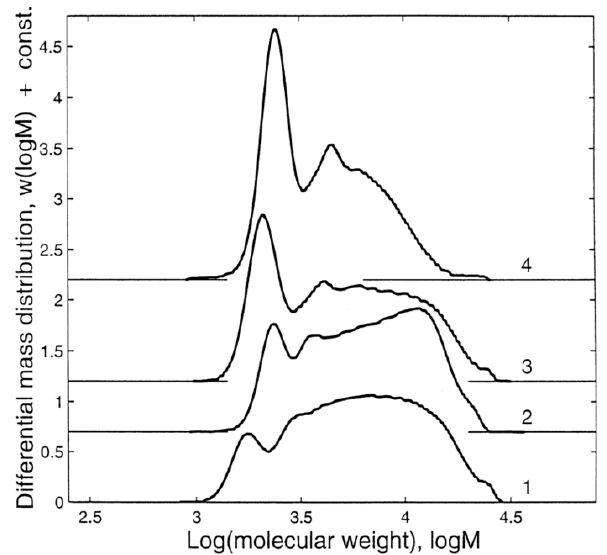
Figure 18. Schematic diagram to show the oligomerization steps. Reprinted with permission from [58]. Copyright Elsevier, 2015.